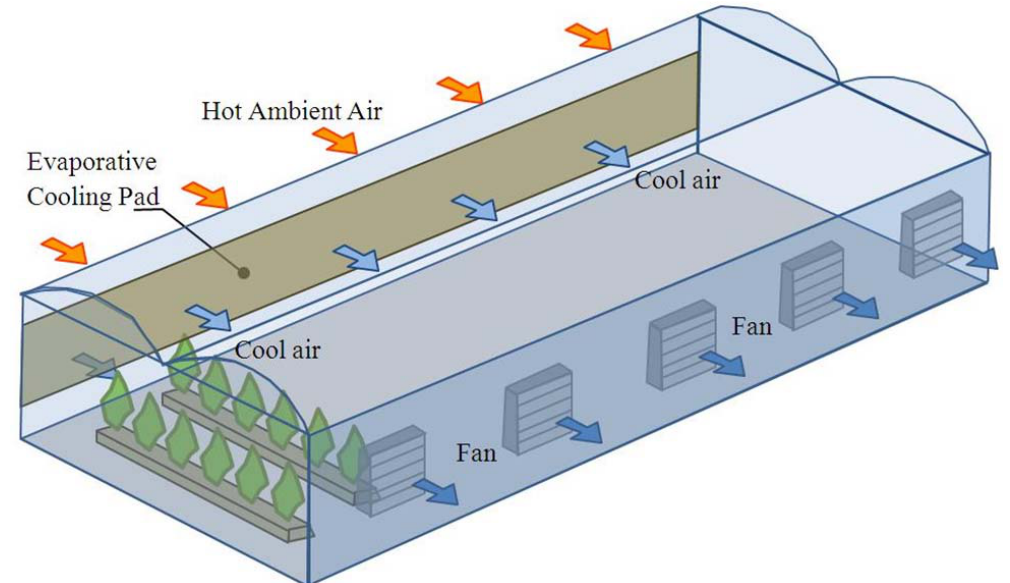
Figure 1. Pad-fan evaporative cooling in